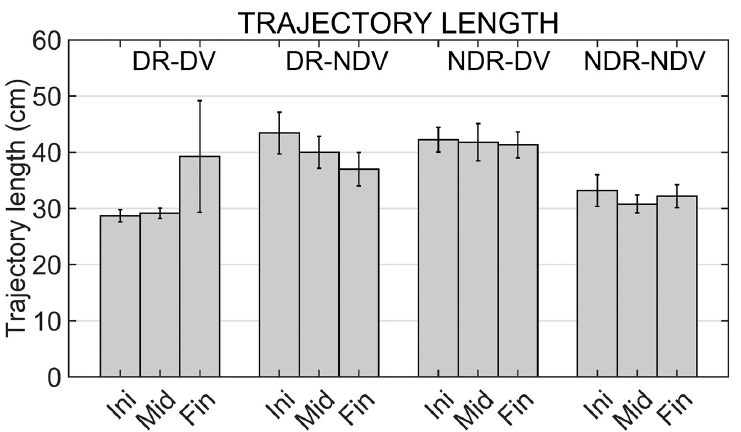
Figure 7. Trajectory lengths in the different experimental conditions (DR_DV, DR_NDV, NDR_DV and NDR_NDV) and in the different moments of the training (Initial, Middle and Final moments). Mean values and standard errors of the mean are shown.